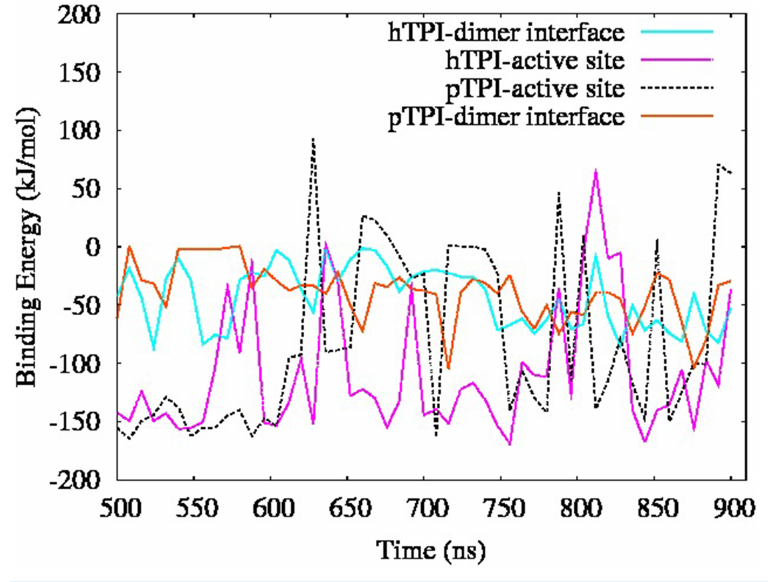
Figure 6 Binding energy last 400 ns of simulation. The cyan curve represents the binding energy (pTPI-Active Site), pink (hTP-Active Site), black (pTPI-dimer interface), blue (hTPI-dimer